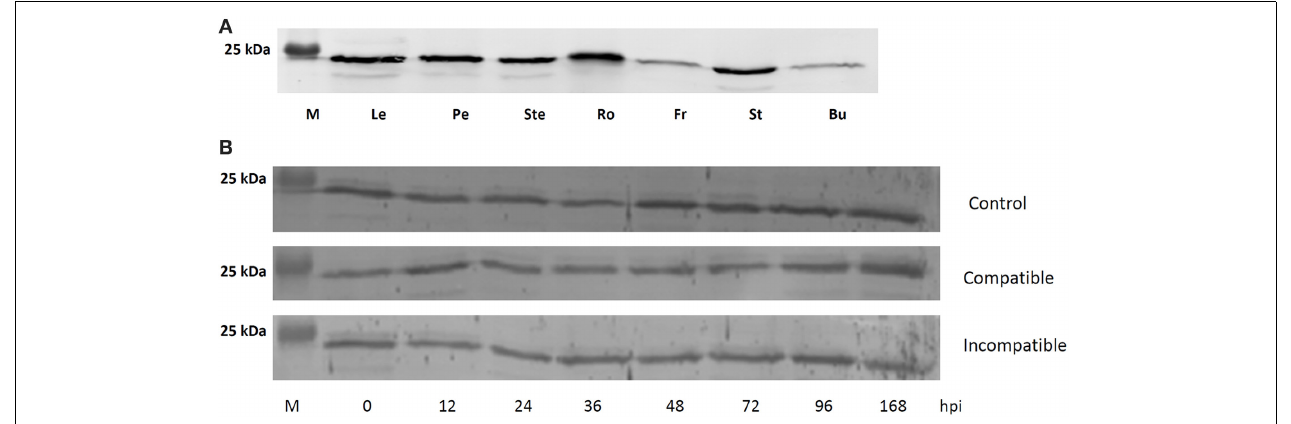
FIGURE 4 | GSTF1 protein abundance in poplar organs and in rust-infected leaves. (A) Western blot analysis was performed from 30 μ g of soluble protein extracts from leaves (Le), petioles (Pe), stems (Ste), roots (Ro), fruits (Fr), stamens (St), and buds (Bu). (B) Western blot analysis from 30 μ g of soluble protein extracts from leaves infected or not with virulent or avirulent isolates of M. larici populina